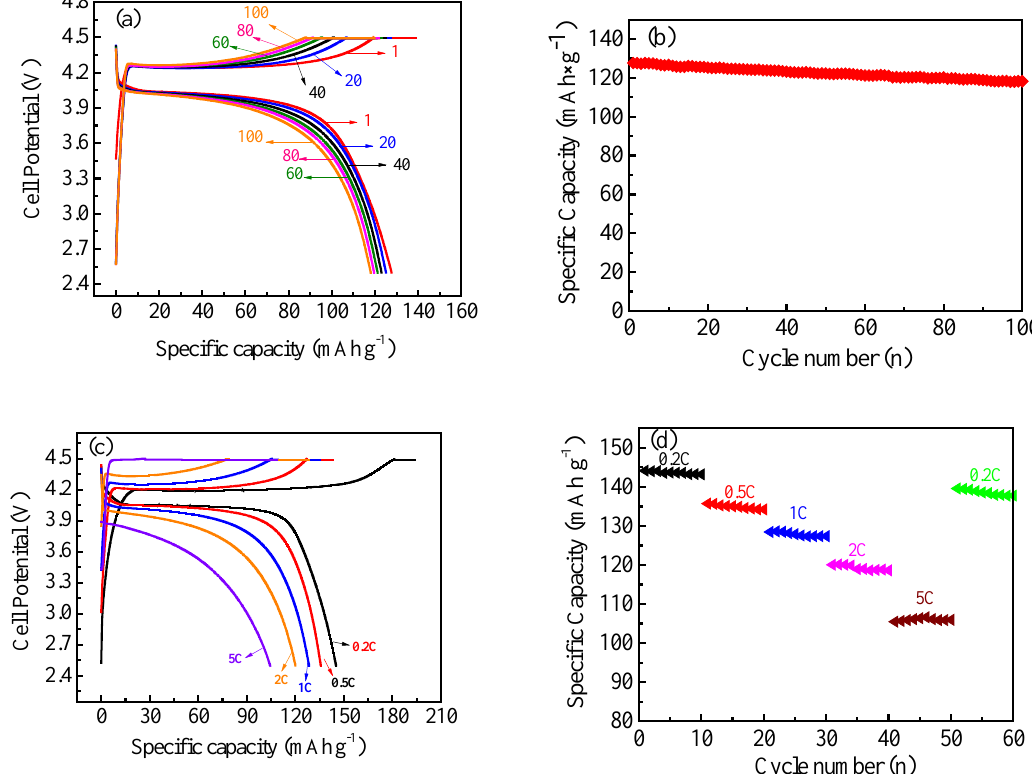
Figure 7. Electrochemical properties for the prepared LiMnPO 4 /C: ( a ) charge-discharge curves at 1 C rate; ( b ) cycle performance at 1 C rate; ( c ) charge-discharge curves at different rates; and ( d ) rate performances at different rates.